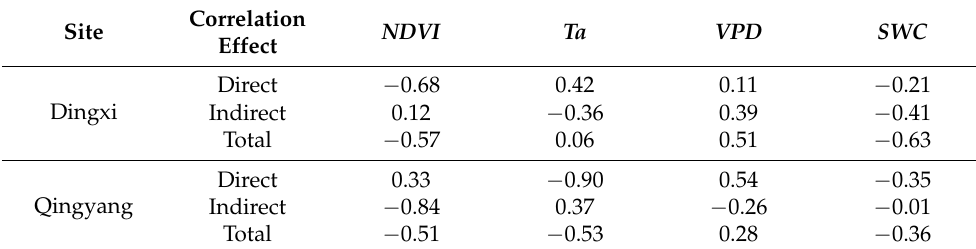
Table 6. Path coefficient between Bowen ratio and impact factor.